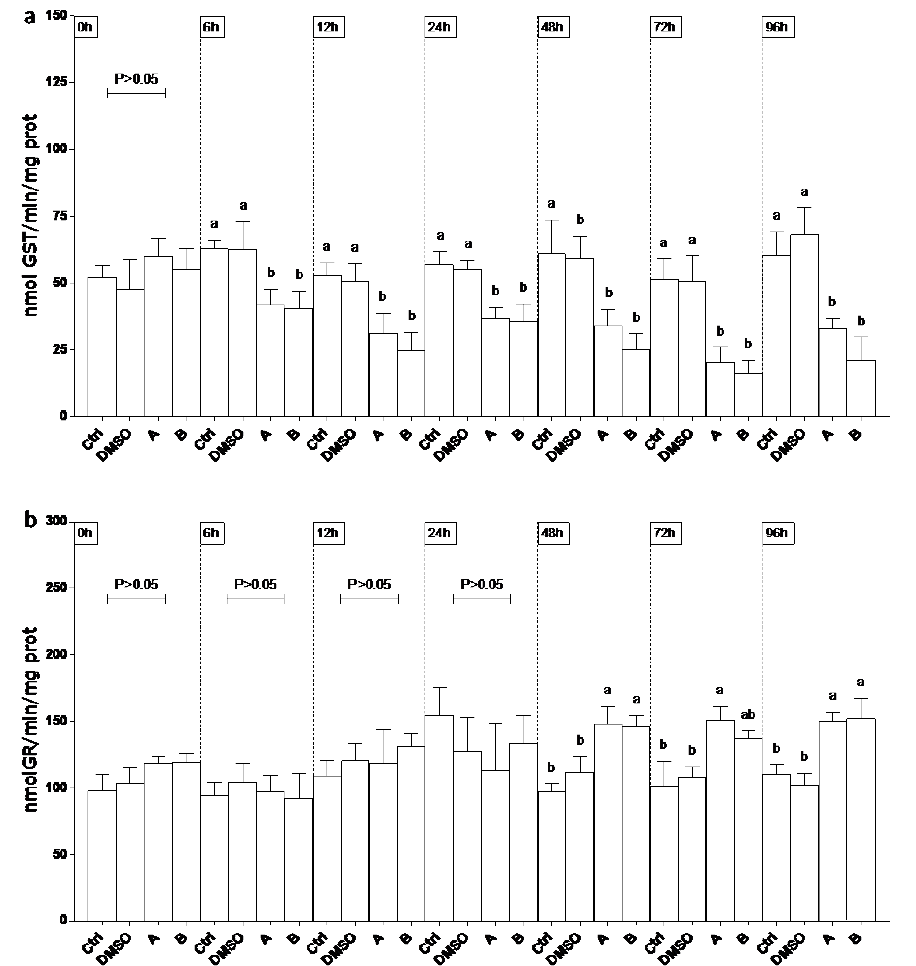
Figure 3. Glutathione S-transferase (GST; ( a )) and glutathione reductase (GR; ( b )) activity in epithe- lioma papulosum cyprini (EPC) cell line exposed to concentrated drinking water from sites A and B. Ctrl denotes control. Different lowercase letters indicate statistically significant differences ( p < 0.05) between the two groups at the same time point.